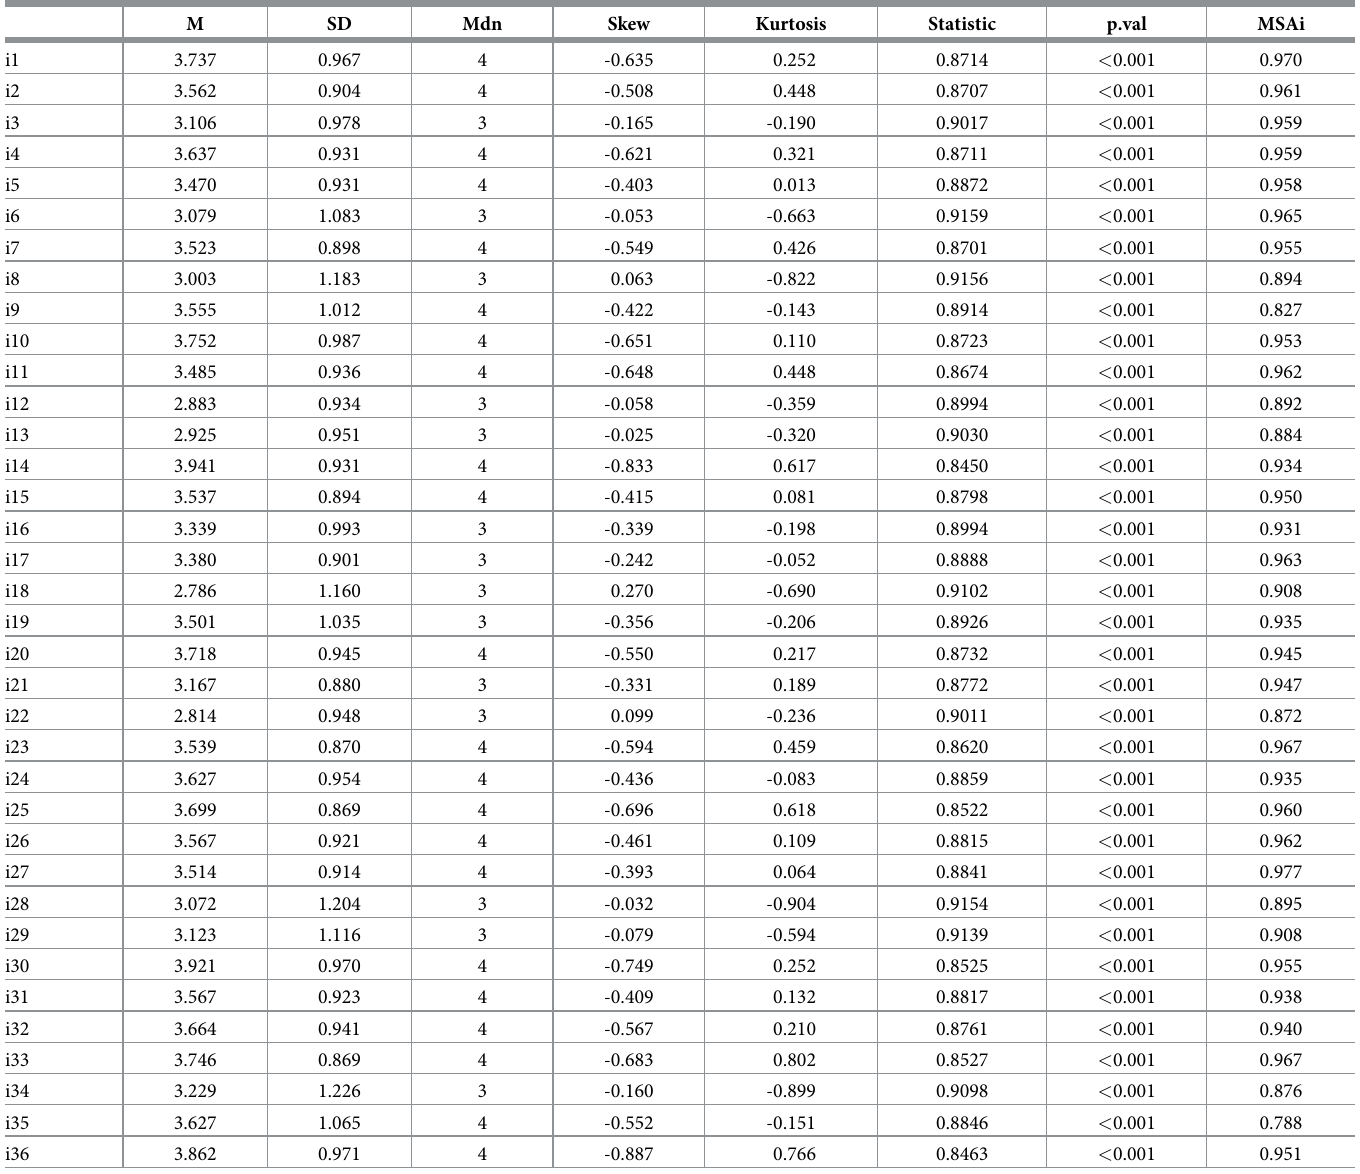
Table 1. Descriptive statistics, normality test, and MSA of the